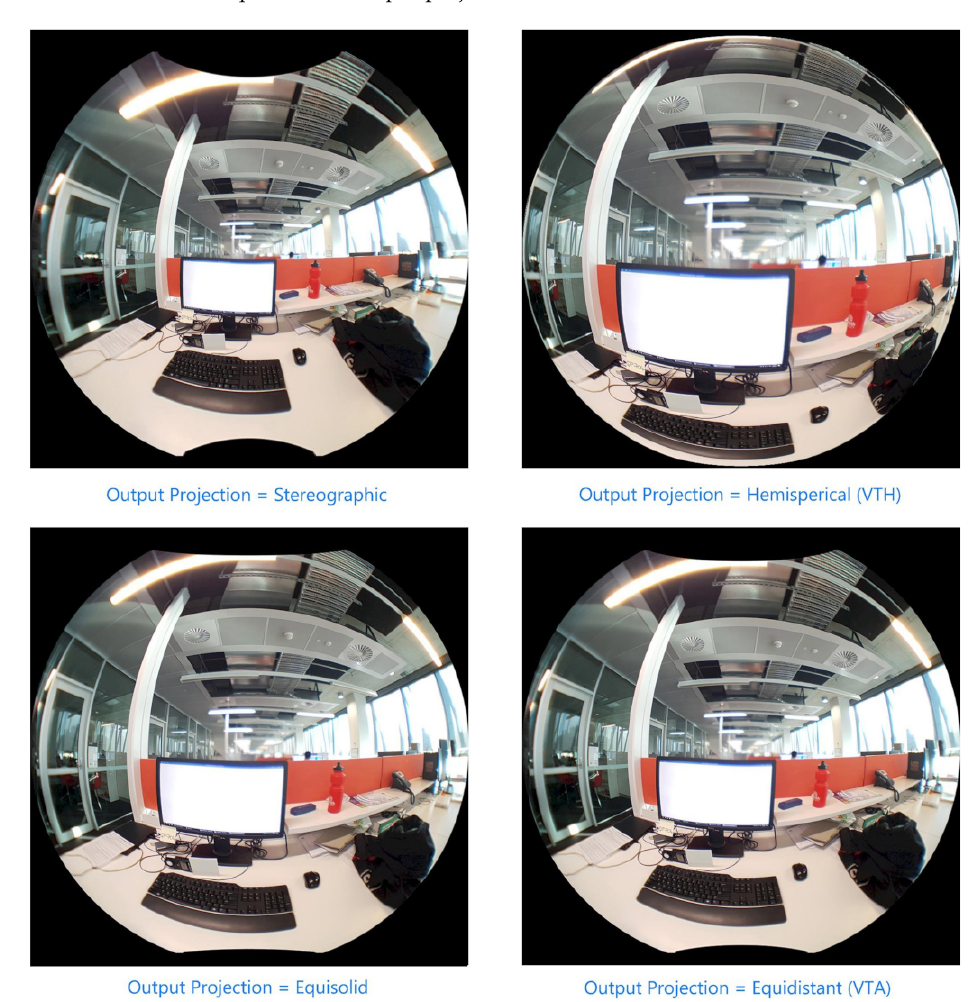
Figure 12. The test scene in di ff erent fisheye projection after calibration and remapping